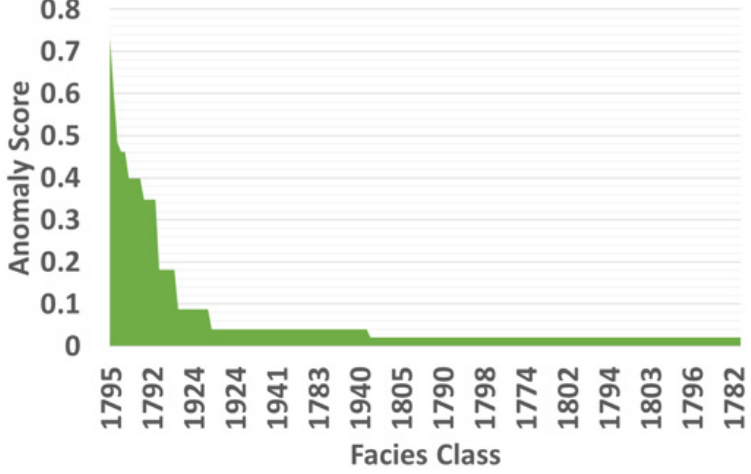
Figure 15. Activation maps visualizing paths (unsupervised).